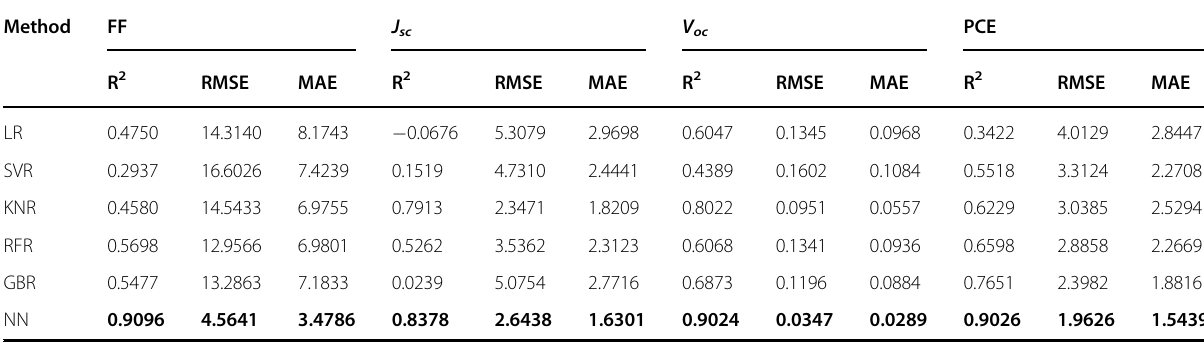
Table 2 The prediction performance of different regression algorithms for four targets (FF, J sc , V oc and PCE) in designing PSCs device using experimental E g , Δ H and Δ L as inputs